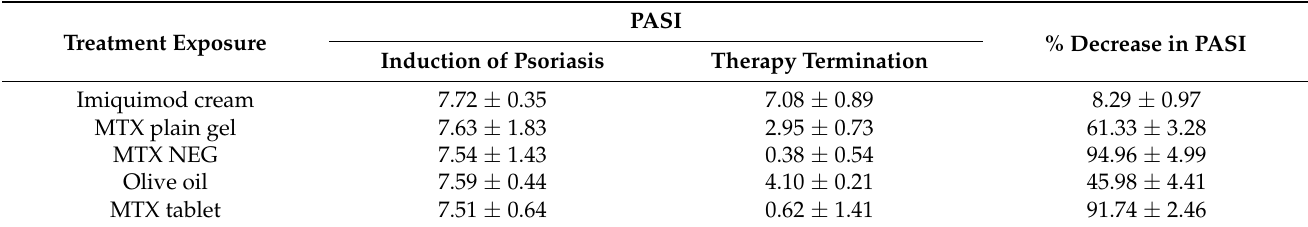
Table 7. PASI decrease % after 28 days.